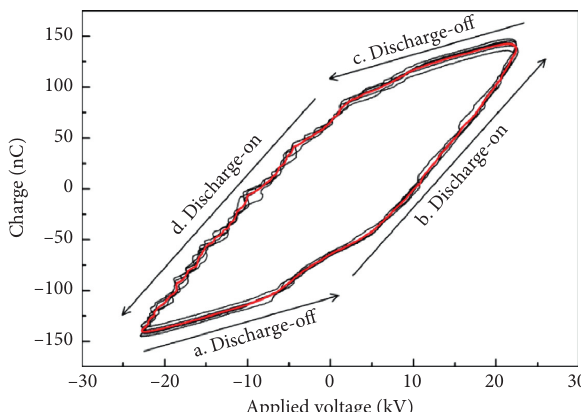
Figure 6: Typical presentation of Lissajous figure from sinusoidal voltage driven the coaxial